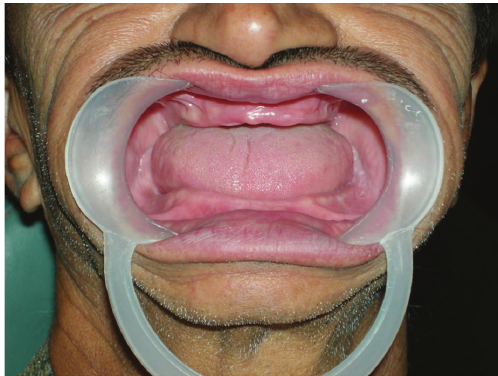
Figure 1: Preoperative view: complete edentulous arches.